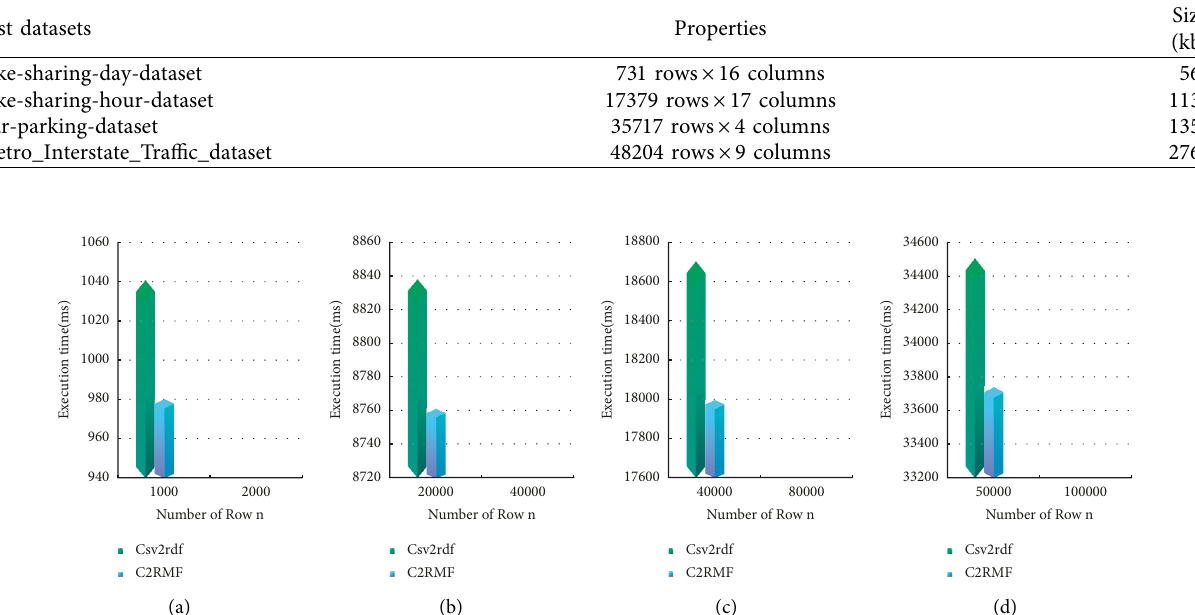
Figure 7: (a) Conversion execution time on the bike-sharing-day-dataset. (b) Conversion execution time on the bike-sharing-hour-dataset. (c) Conversion execution time on the car-parking-dataset. (d) Conversion execution time on the Metro_Interstate_Traffic_dataset.